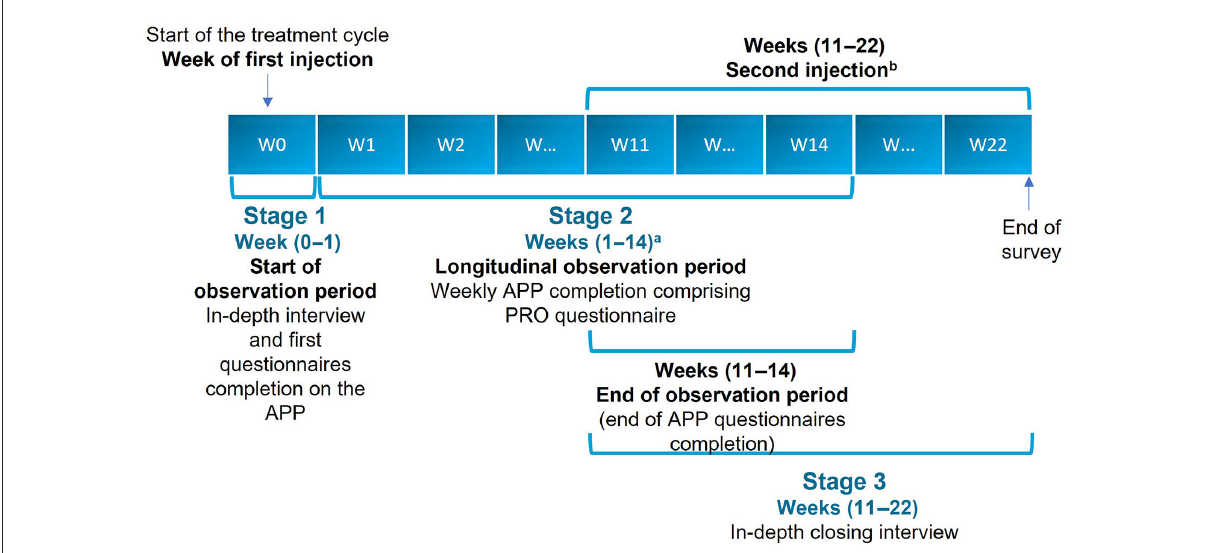
FIGURE1 Study flowchart. a Weekly completion of all sections of the APP, except the WHODAS 2.0, which was completed monthly. b Except for two patients who did not receive their second injection by Week 22. APP, application; PRO, patient-reported outcome; W,